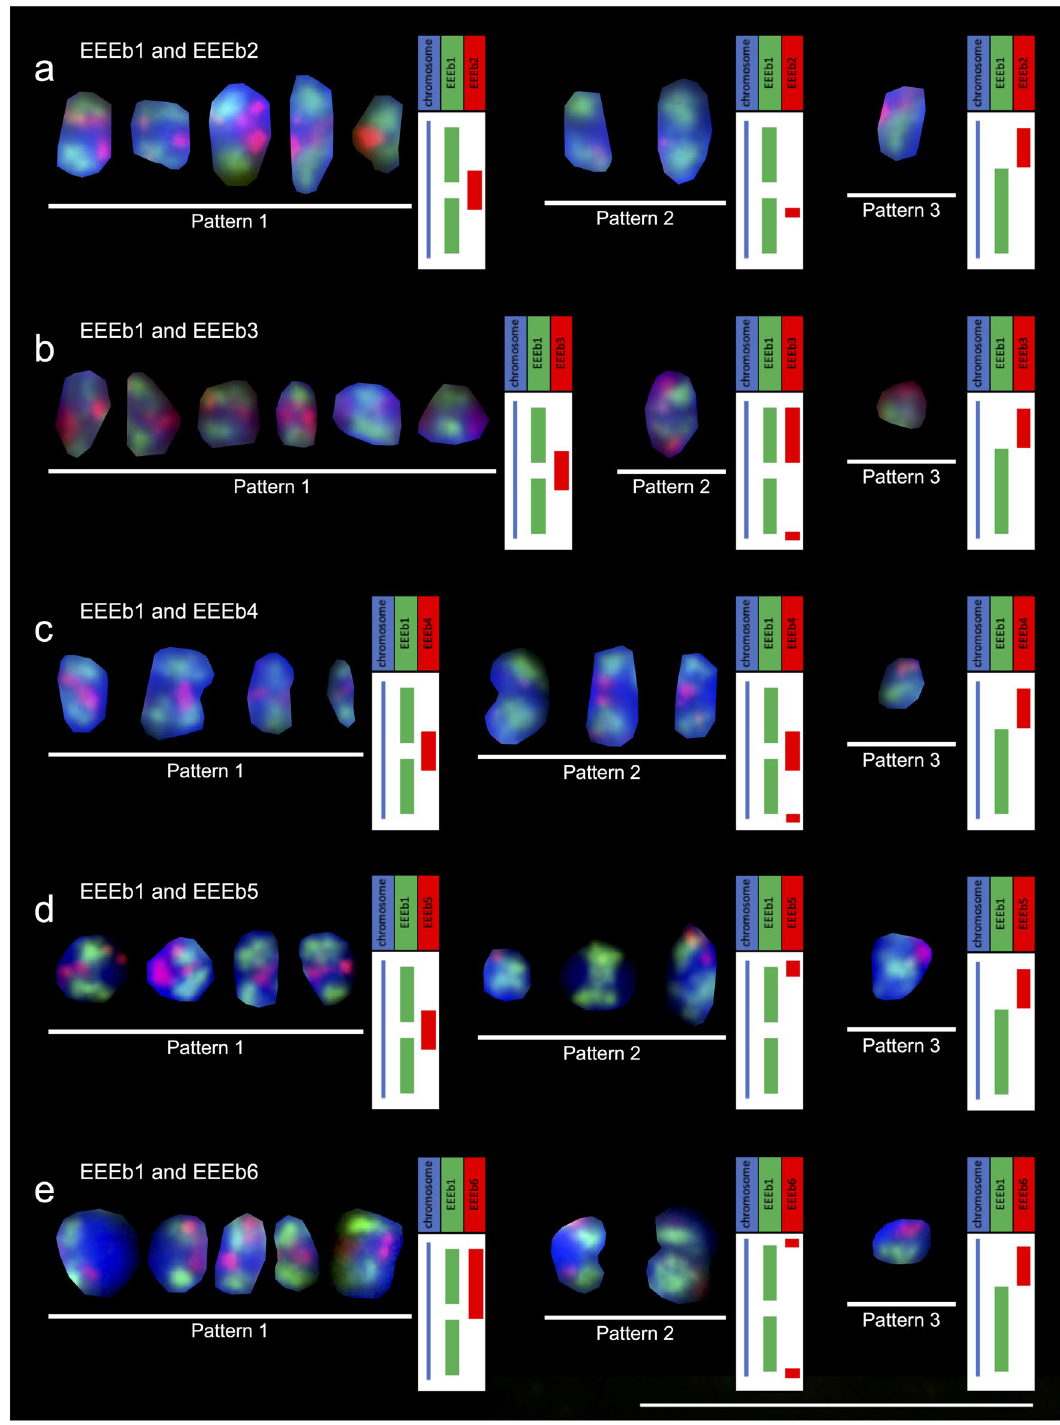
Figure 5. Karyogram of E-chromosomes and schematic diagrams of six eliminated DNA families in E. burgeri . Eight pairs of E-chromosomes were divided into three patterns (Pattern 1 to 3) by their signal localizations. Schematic diagrams were shown at the right of chromosomal images of each signal distribution patterns. Scale bar = 5 μm. The other notions correspond to those to in Fig.